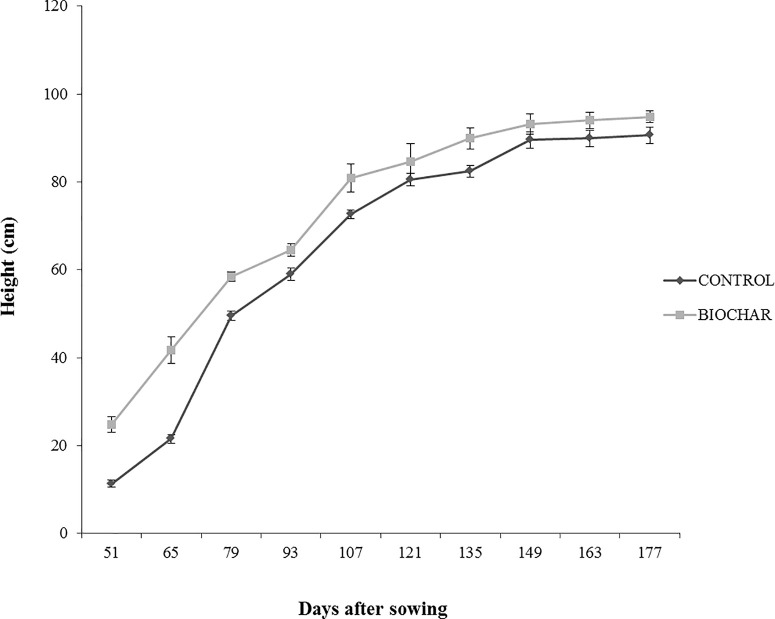
Average height (in cm) of tomato plants experiencing low-input farming conditions in soils amended with or not with 5% Verfofood biochar. Measurements were performed the 50th day after sowing using one sample per five pots.